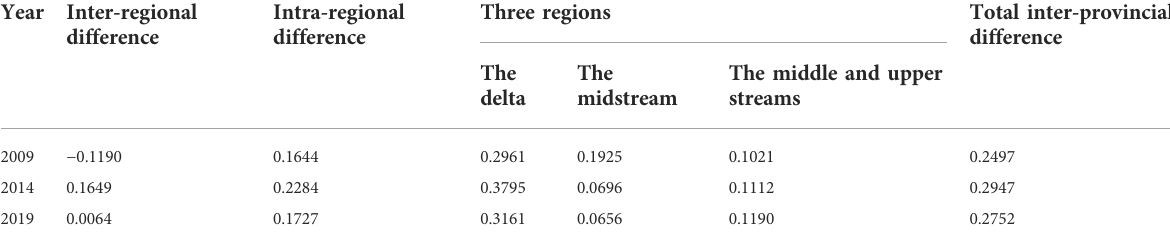
TABLE 3 Theil index measurement and contribution rate